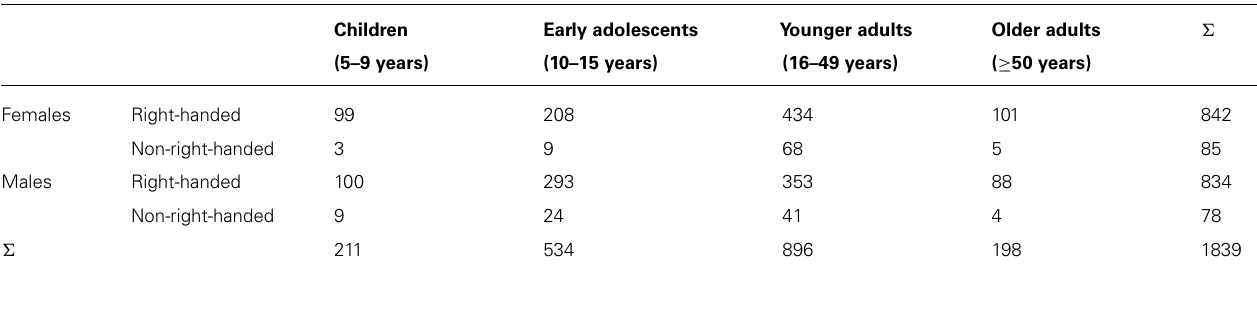
Table 1 | Number of participants in the Bergen DL database across age, sex, and